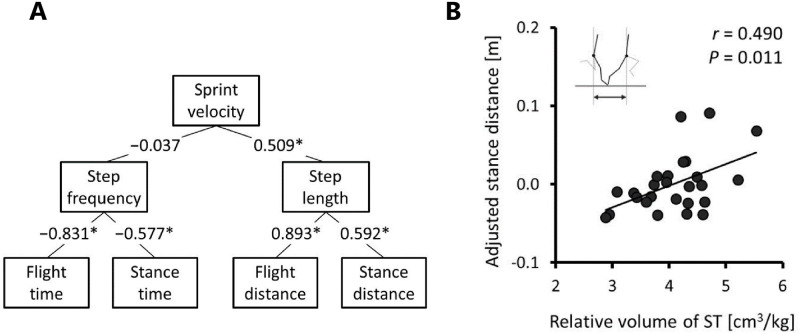
A, Simple correlation coefficients between the sprint velocity and the spatiotemporal variables at 50–60 m interval of a 100-m sprint. * indicates P < 0.05. The values show the correlation coefficients between the variables. B, The relationship between the semitendinosus (ST) volume relative to the body mass and the adjusted stance distance at 50–60 interval of a 100-m sprint. The stance distance was adjusted by the stance time using a semi-partial correlation analysis.